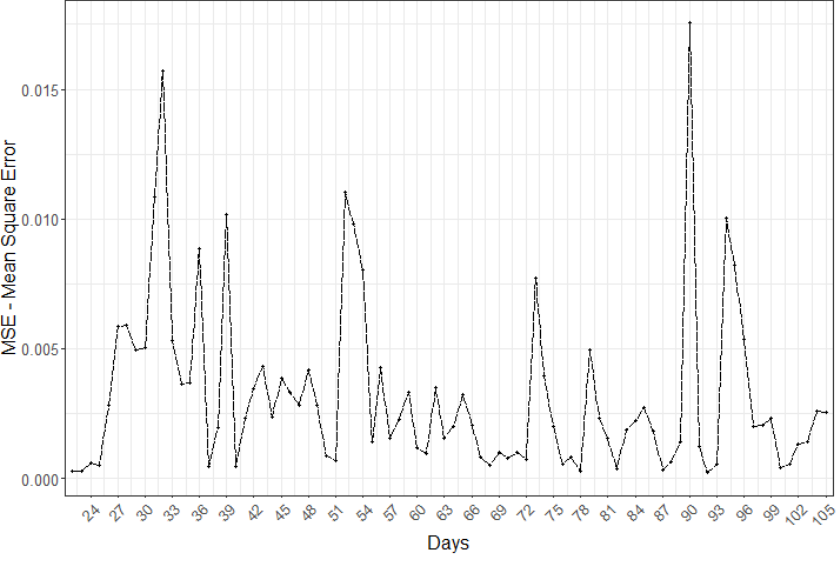
Figure 9. The daily MSEs from days 22 to